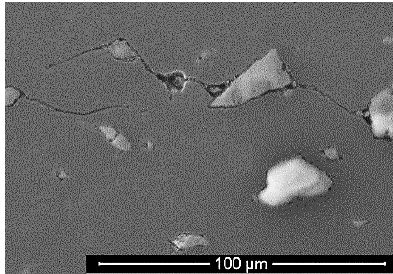
Figure 18. Crack propagation in the 20% ZrO 2 matrix (magnification: 1500×)